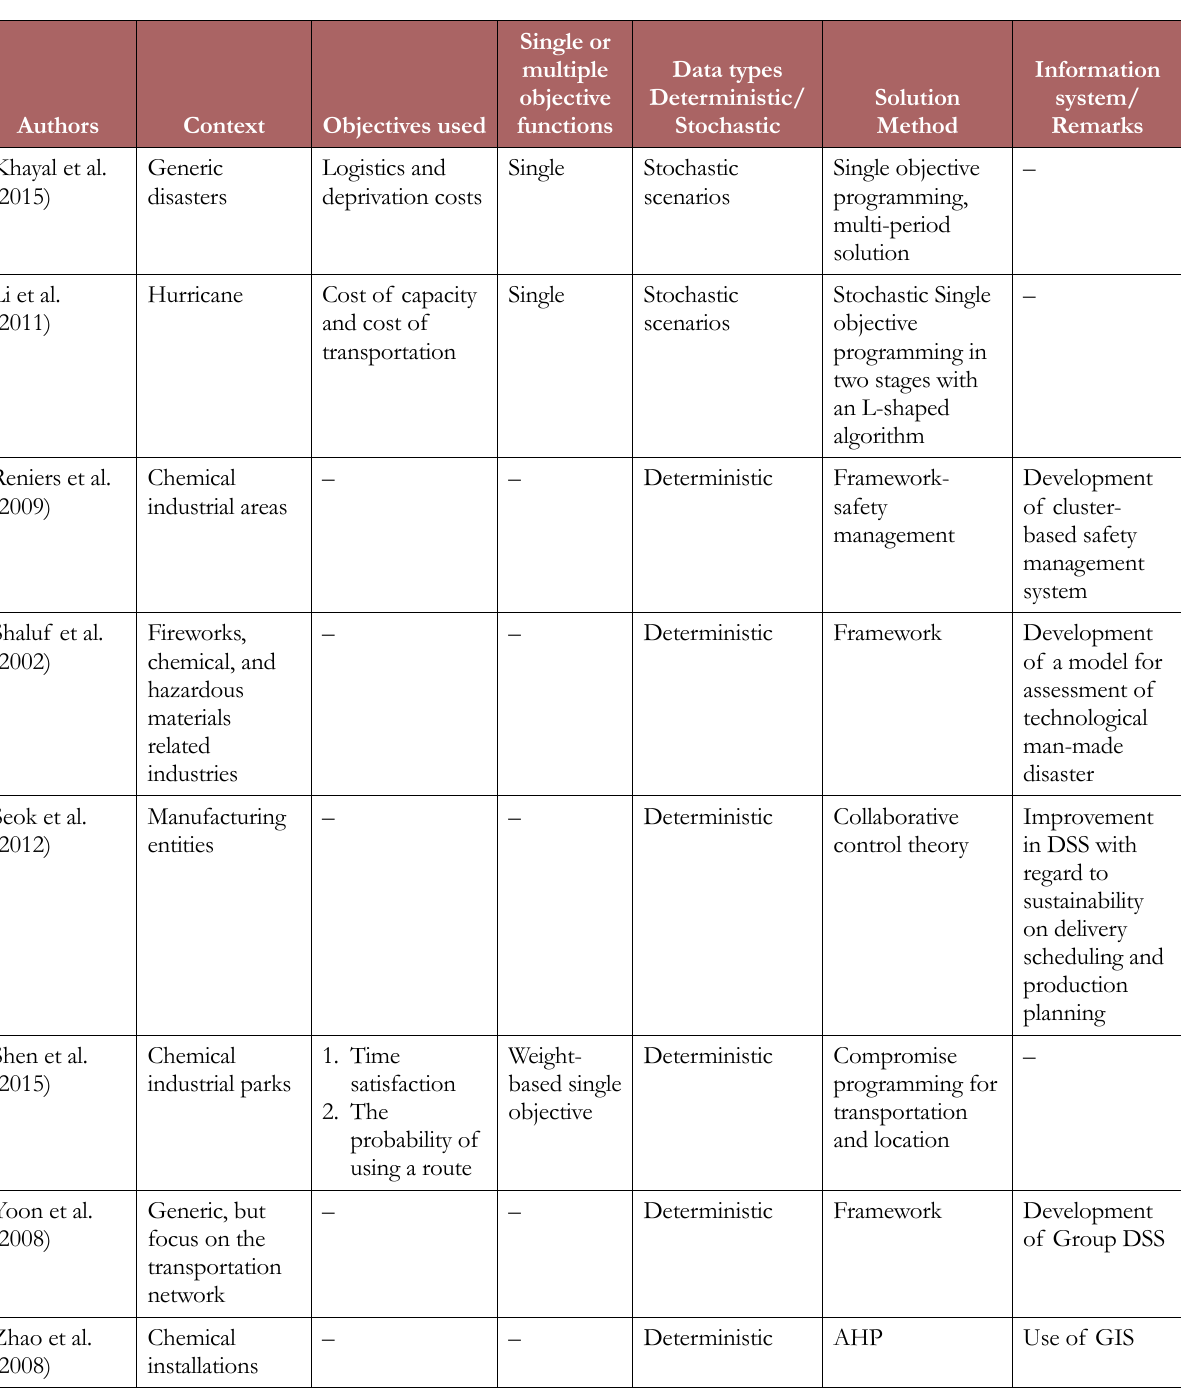
Table 1. Modeling frameworks for preventive